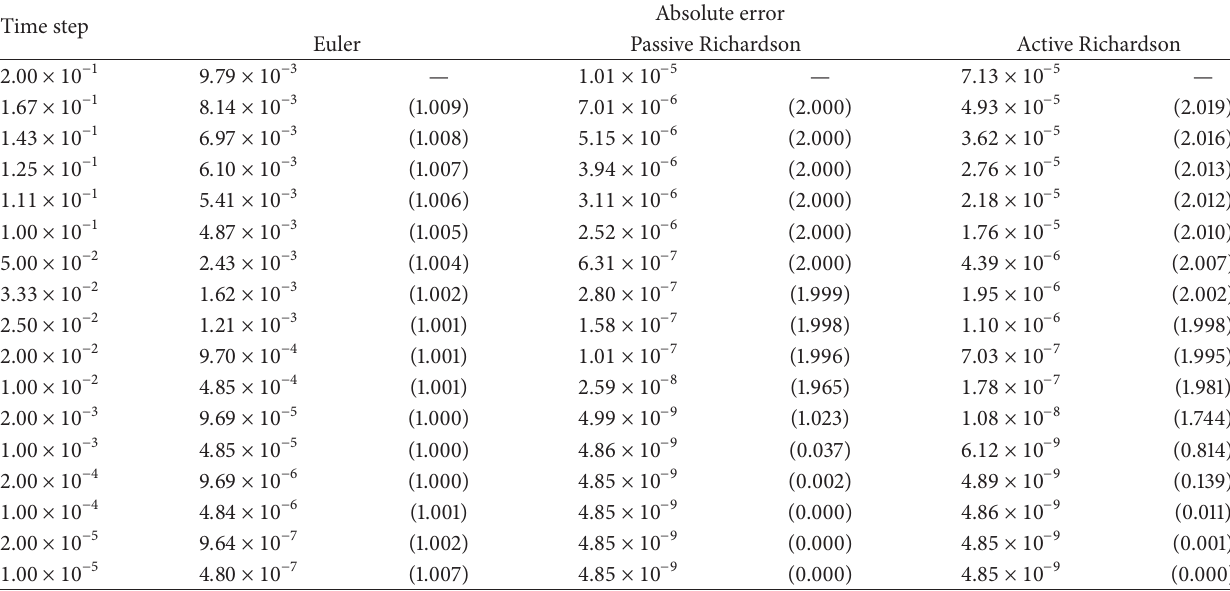
Table 5: Absolute error of the advection problem without and with passive/active Richardson extrapolation (with the estimated convergence order in parentheses).